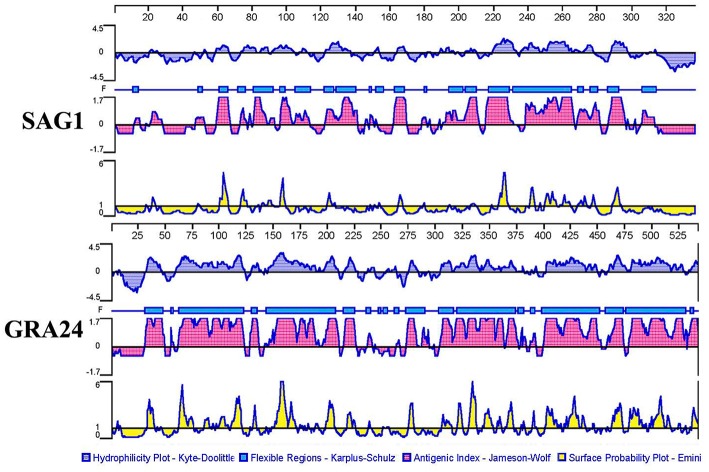
Plot of the DNASTAR-predicted hydrophilicity, flexible regions, antigenic index, and surface probability plot of the linear-B cell epitopes of GRA24 compared with those of SAG1.